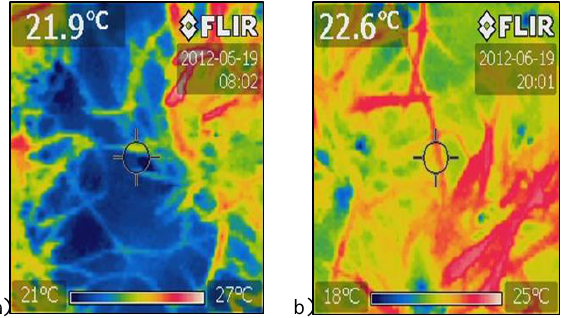
Figure 7: Nadir FLIR measurement of under test sample; a) Daytime measurements, b) Nighttime measurement On the top left corner of each image the average surface temperature of the samples are shown. Moreover the gradient temperature scale bar is provided in the lower part of each image, and the minimum and maximum values are shown respectively in left and right part of this scale bar.